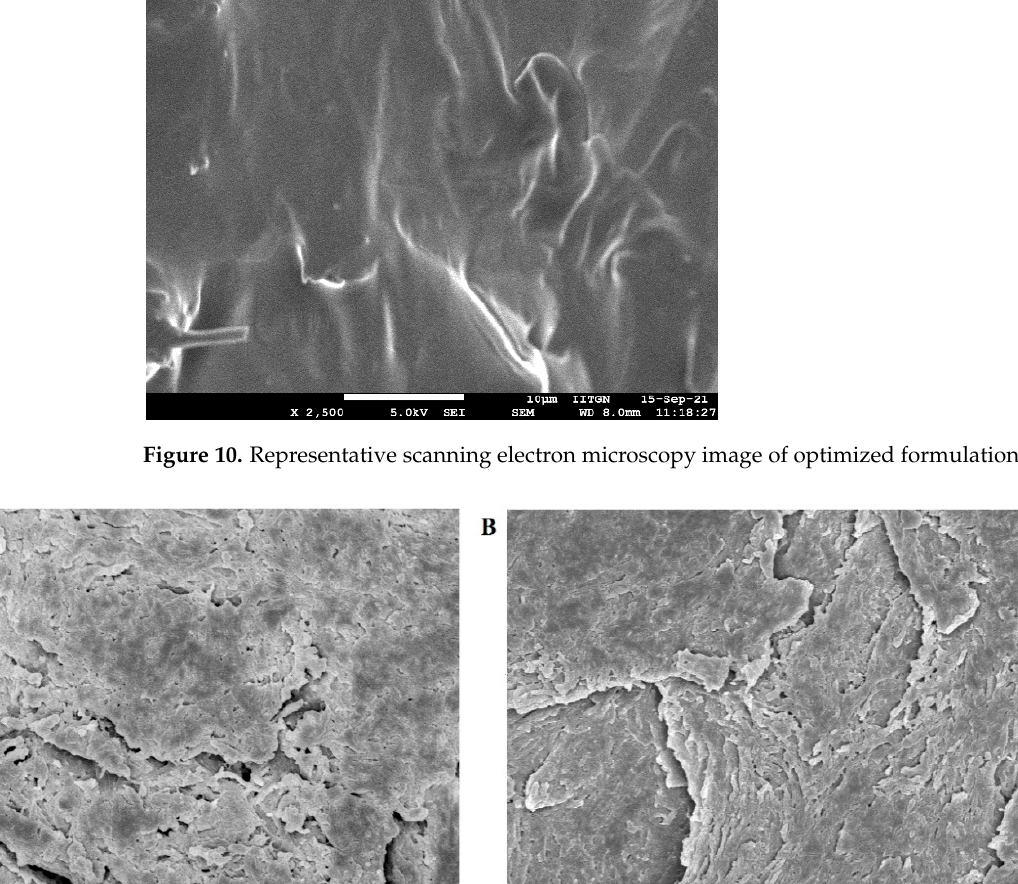
Figure 10. Representative scanning electron microscopy image of optimized formulation (F8).